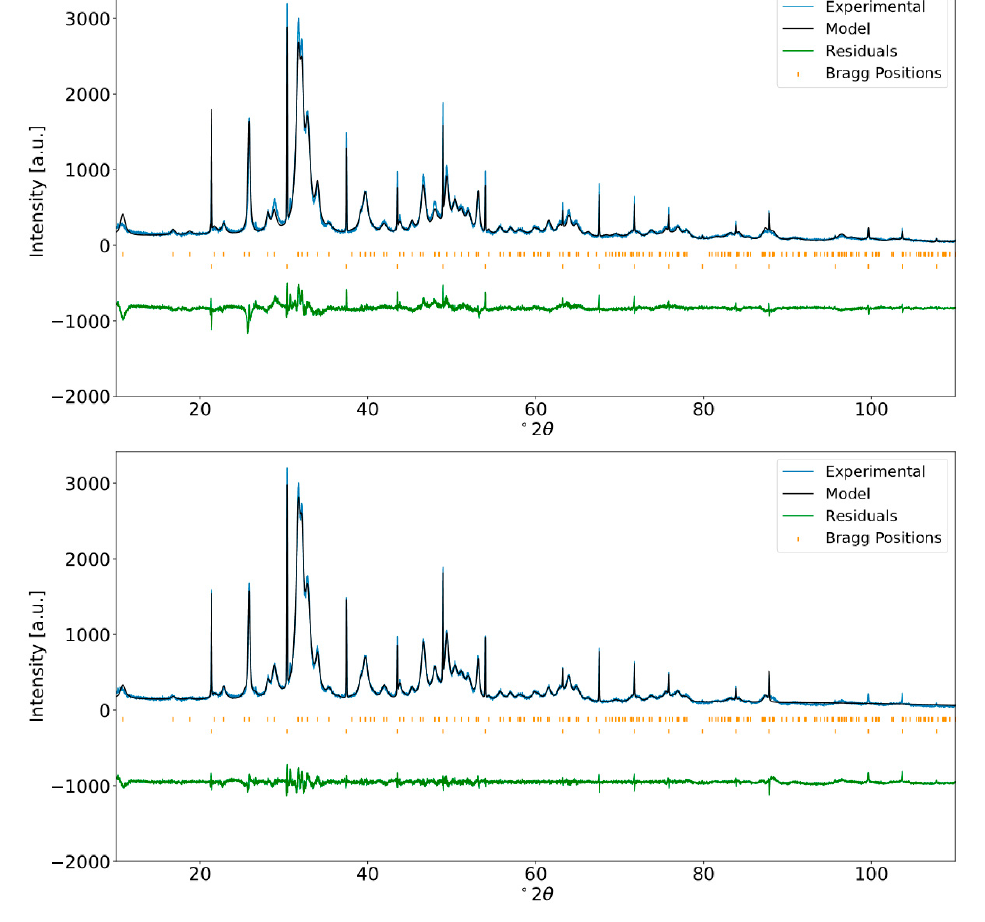
Figure 2. Rietveld refinement (top) and Le Bail fit (bottom) of the XRPD profile for bone material from